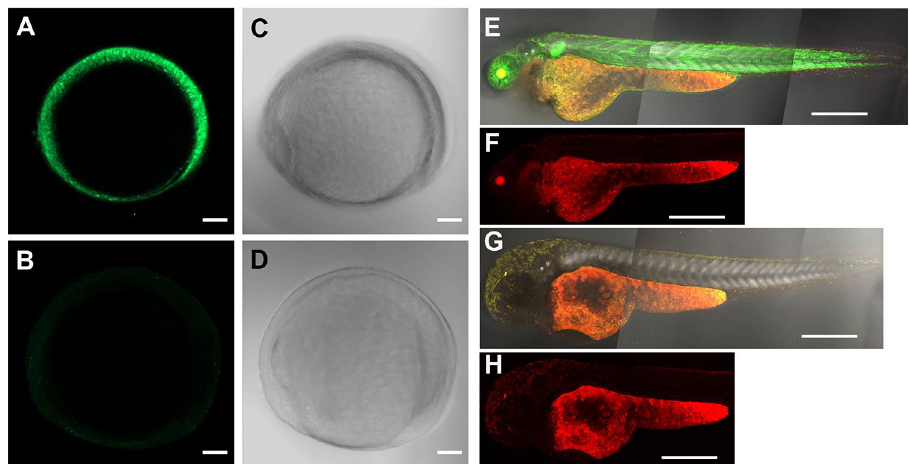
Figure 5. Strong Adamts9 expression in F2 transgenic ( Tg(adamts9:GFP) zebrafish embryos. The expression of Adamts9 was determined by EGFP expression driven by adamts9 promoters located in a 4.5 kb upstream sequence of adamts9 start codon. Same conditions were used for imaging embryos under the EGFP, red (for monitoring autofluorescence), and transmit light (T-PMT) channels. Picture ( A ) is z-stack confocal images of a representative F2 transgenic embryo at 10 h post fertilization (hpf) from GFP channel; Picture B is a wildtype control embryo imaged under same condition. Pictures ( C ) or ( D ) are corresponding images of same embryo from pictures A or B using T-PMT channel. Pictures ( E , F ) are confocal z-stack images of a representative F2 transgenic embryo at 48 hpf, while pictures ( G , H ) are confocal z-stack images of a wildtype embryo at 48 hpf. Pictures ( E , G ) are merged confocal z-stack images from all three channels, while pictures ( F , H ) were confocal z-stack images from red channel to show background. Scale bar: 100 μm ( A – D ), 400 μm ( E – H